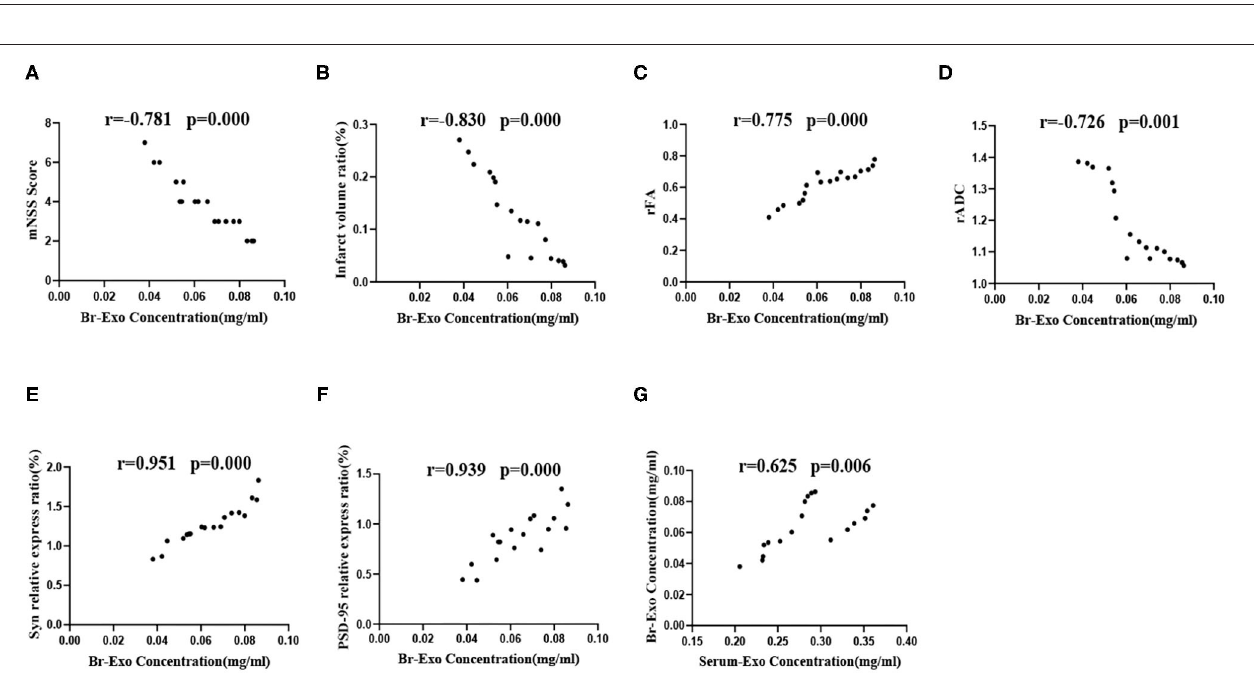
FIGURE 7 | AA, right forepaw → right hindpaw → left forepaw → left hindpaw; AB, left forepaw → right hindpaw → right forepaw → left hindpaw. # p < 0.05, ## p < 0.01, and ### p < 0.001 compared with the corresponding SED-MCAO group. + p < 0.05 compared with the corresponding EX-MCAO group. Means ± standard deviations, n = 6/group.